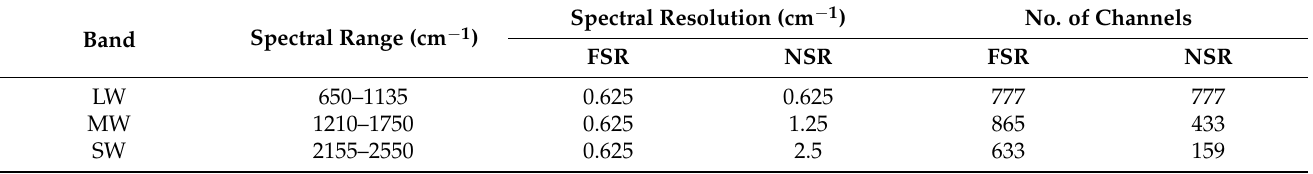
Table 1. The HIRAS spectral